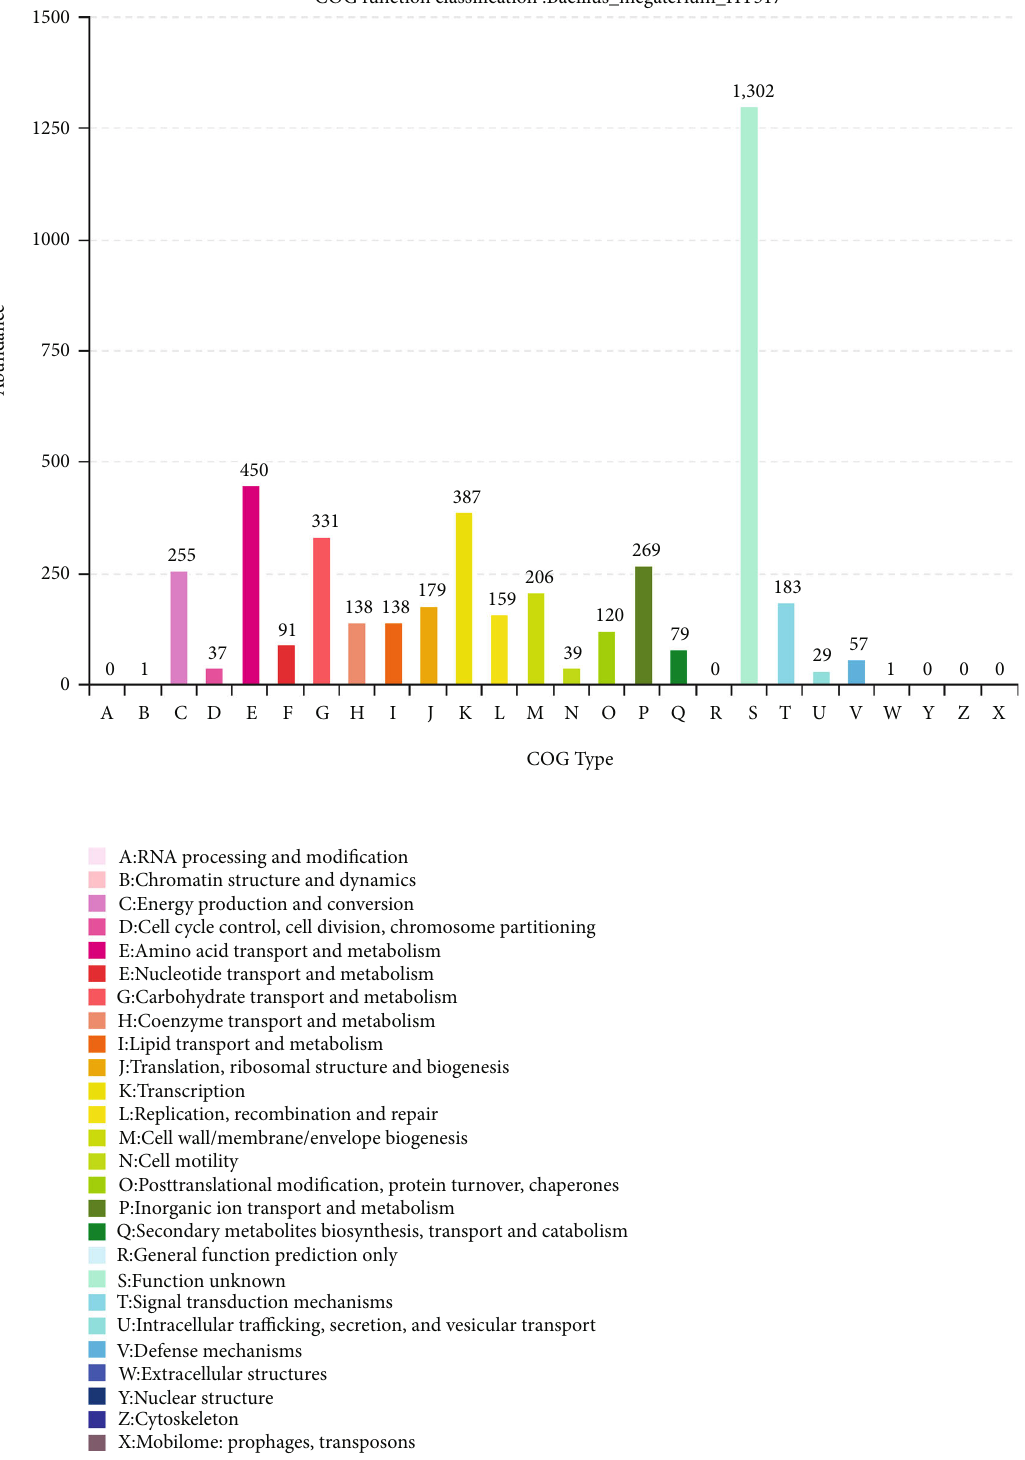
Figure 7: COG classi fi cation statistics of Bacillus megaterium shown in Figure 5, B. megaterium HT517 could secrete lysine, L -isoleucine, L -pipecolic acid, 5-aminopentanal, and (Figure 5(a)), paxilline D -lysine (Figure 5(b)), which participated in the synthesis (Figure 5(c)), pelletierine, piperidine, ecgonine methyl ester, of indole alkaloid biosynthesis (Figure 5(a)), indole diterpene methylisopelletierine, phenyllactic acid, L -phenylalanine, L - alkaloid biosynthesis (Figure 5(c)), and tropane, piperidine,